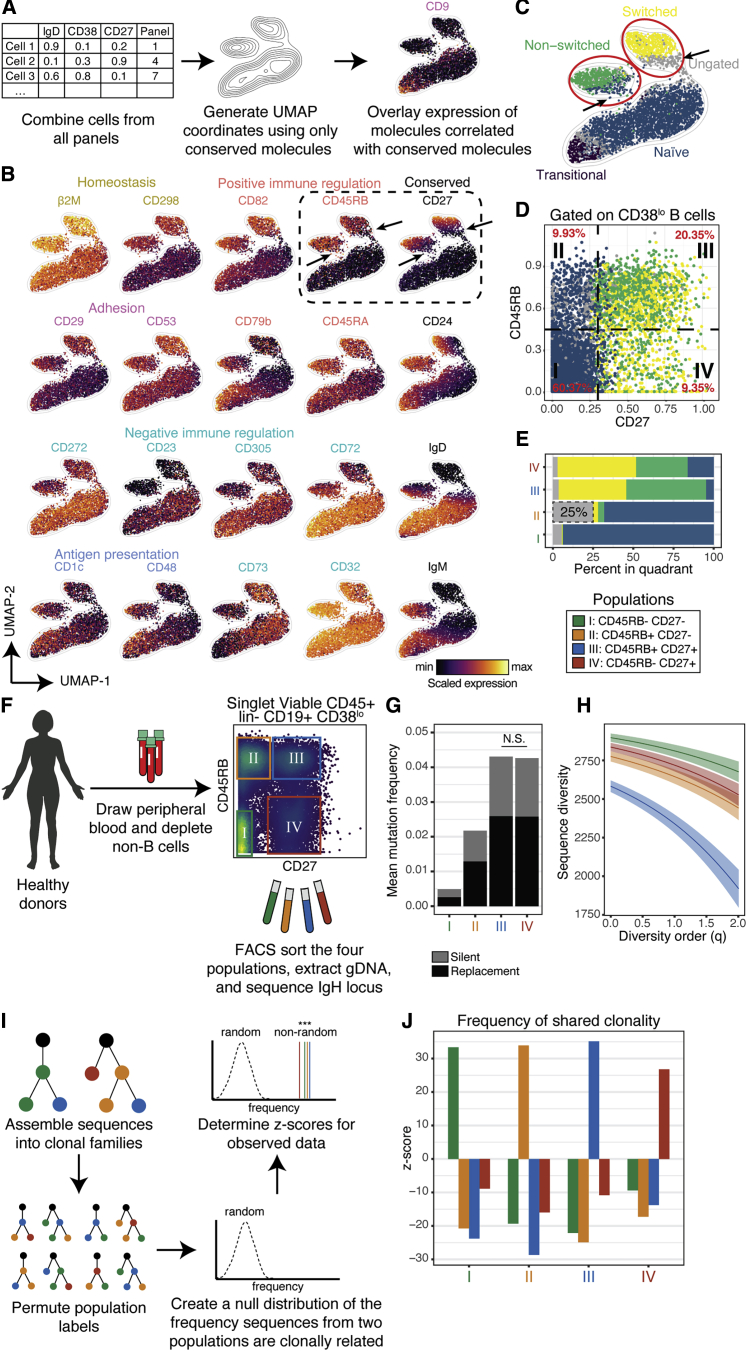
CD45RB marks human memory B cells and identifies an early memory population(A) Computational workflow.(B) UMAP plots of molecules correlated with the conserved molecule in their row. Arrows indicate RB+CD27− cells.(C) UMAP plot colored by subset.(D) Biaxial plot colored by subset. Percent of CD38lo B cells in each quadrant is quantified (red text).(E) Percent of cells in each quadrant from (D).(F) Experimental workflow.(G) Mean IgH mutation frequencies. All pairwise comparisons were significantly different (p < 0.005), except where indicated.(H) Sequence diversity across a range of diversity orders. Shaded regions indicate 95% confidence interval.(I) Computational workflow.(J) Z-scores of frequencies of shared clonality.